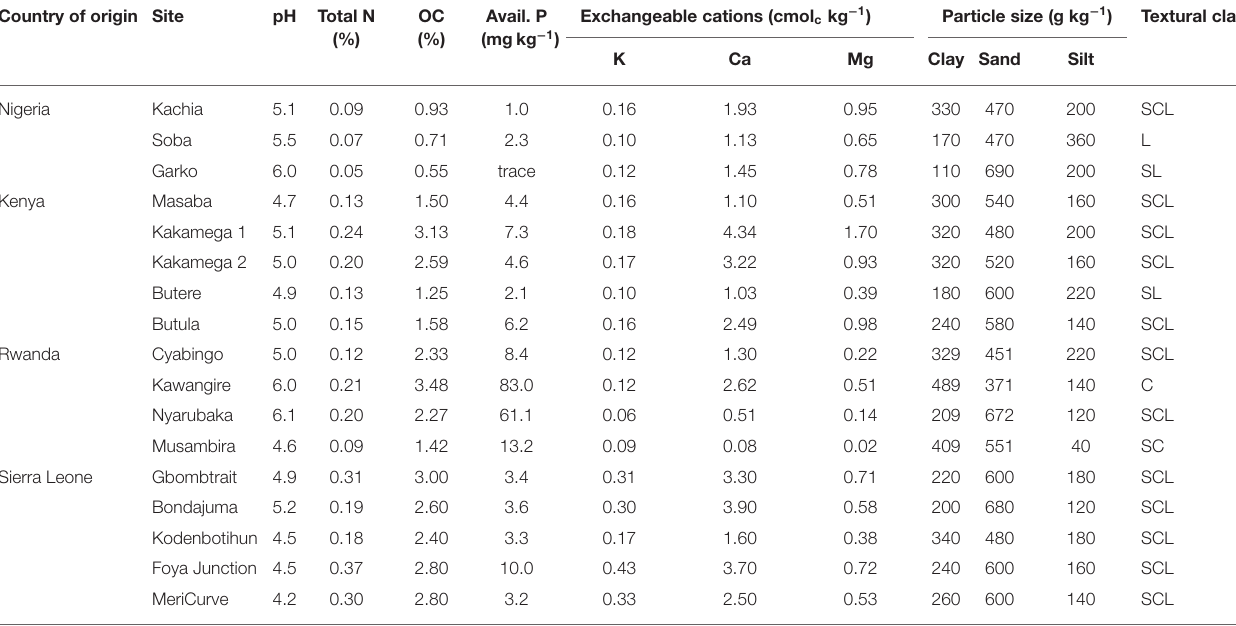
TABLE 2 | Top (0–20cm) soil chemical and physical properties of the soils used in the experiments. Country of origin Site